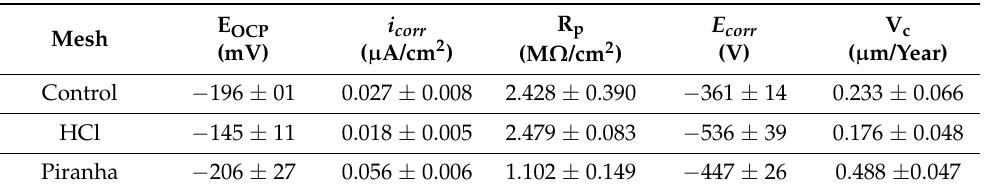
Table 4. Electrochemical and corrosion parameters assessed for Ti alloy meshes with different passivation treatments.